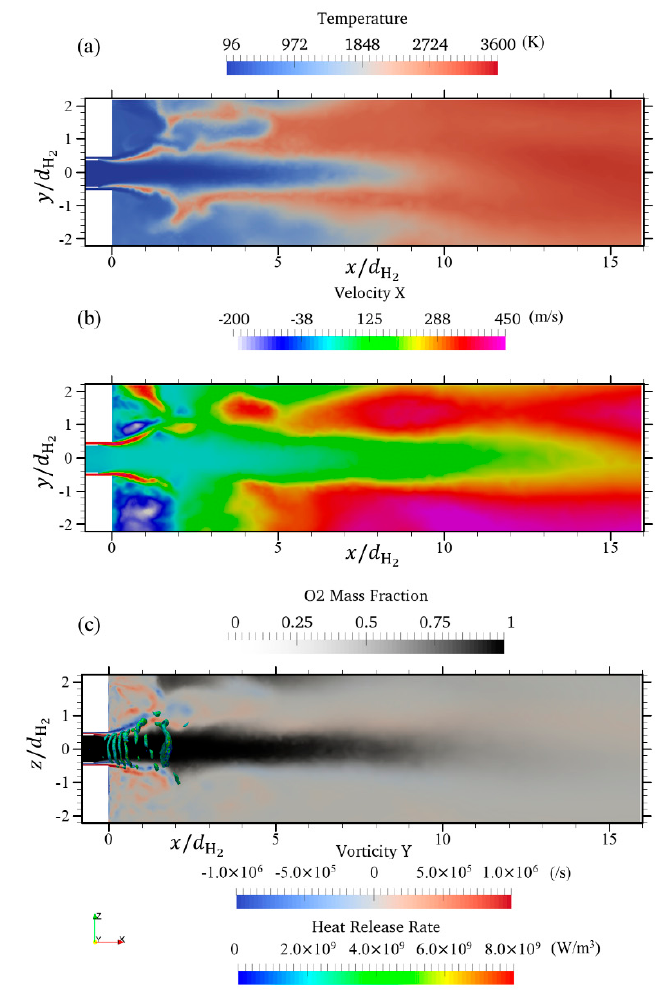
Figure 8. Contour plots of instantaneous ( a ) temperature, ( b ) x -velocity, ( c ) oxygen mass fraction and y -vorticity with iso-contour of the heat release rate in the analysis plane of injector A under the stable condition.